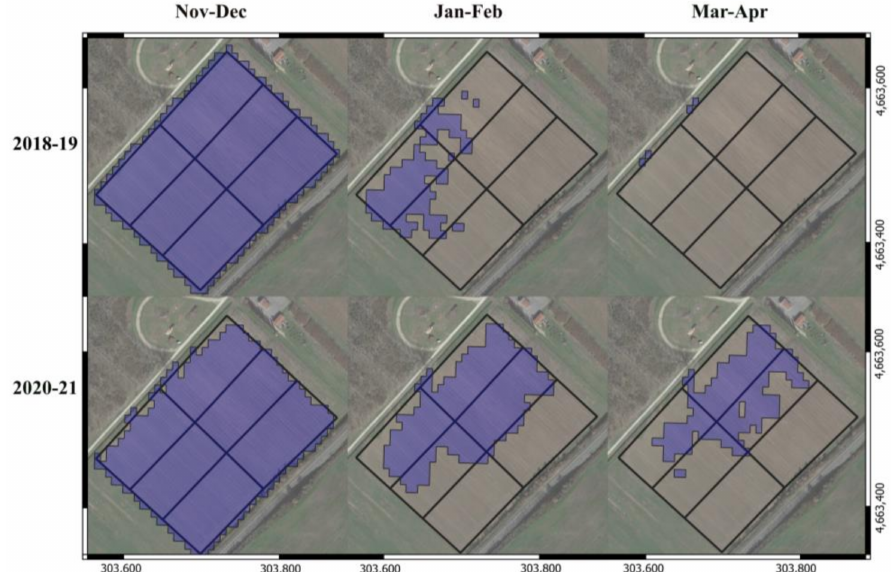
Figure 4. Flooded areas. For each phenological stage (F1 in November-December, F2 in January- February, and F3 in March-April) in year 1 (2018-19) and year 2 (2020-21), a composite image was computed with the maximum values of the Normalized Difference Water Index (NDWI). Pixels with values higher than the threshold of − 0.5, corresponding to the median of the six NDWI maximum images, were gathered in colored polygons, indicating high humidity or flooded